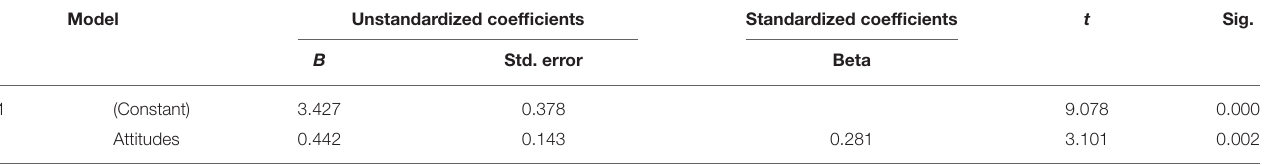
TABLE 2 | Multiple regression statistics to predict teachers’ self-efficacy.